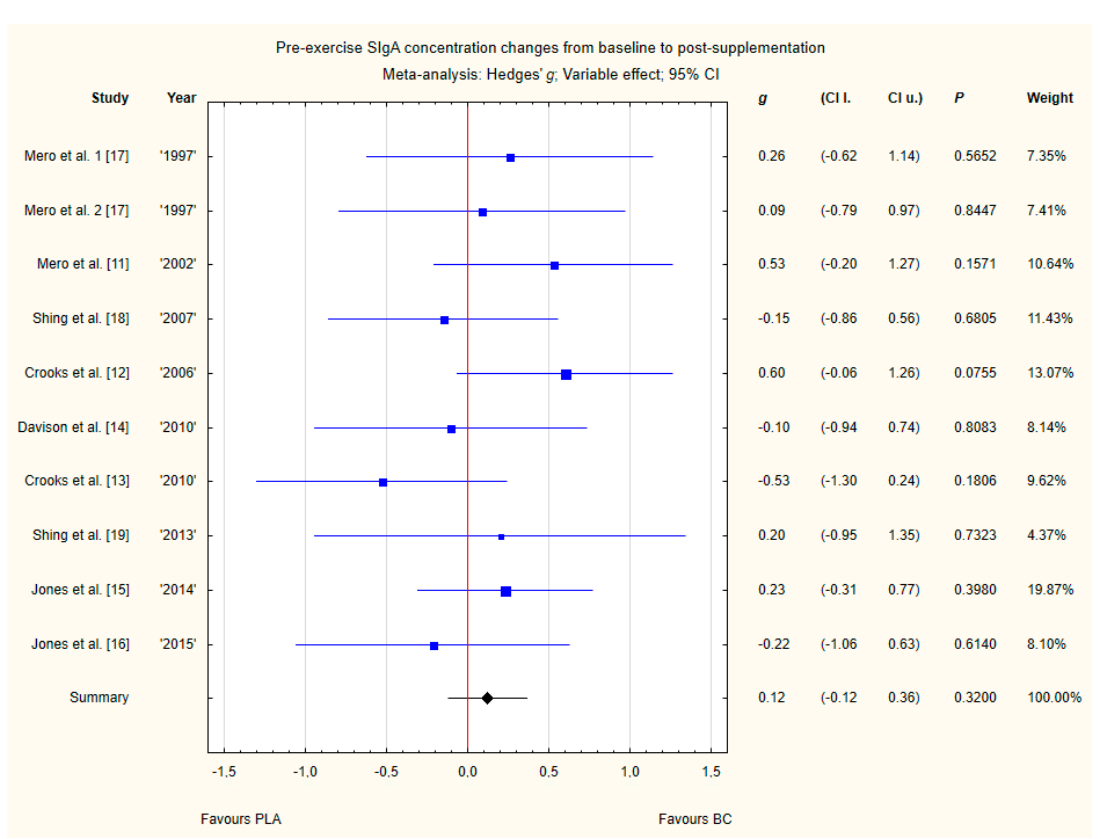
Figure 10. Forest plot of the random-effects meta-analysis of changes from baseline to post-supplementation in pre-exercise SIgA concentration. Heterogeneity: Tau 2 = 0; Chi 2 = 7.65; df = 9; I 2 = 0%; P = 0.57. 1–the first dose from Mero et al. [17] 1997 study, 2–the second dose from Mero et al. [17]